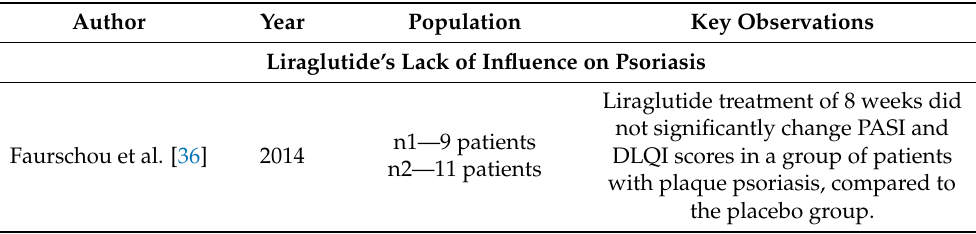
Table 15. Summary of the studies on liraglutide’s lack of influence on psoriasis.